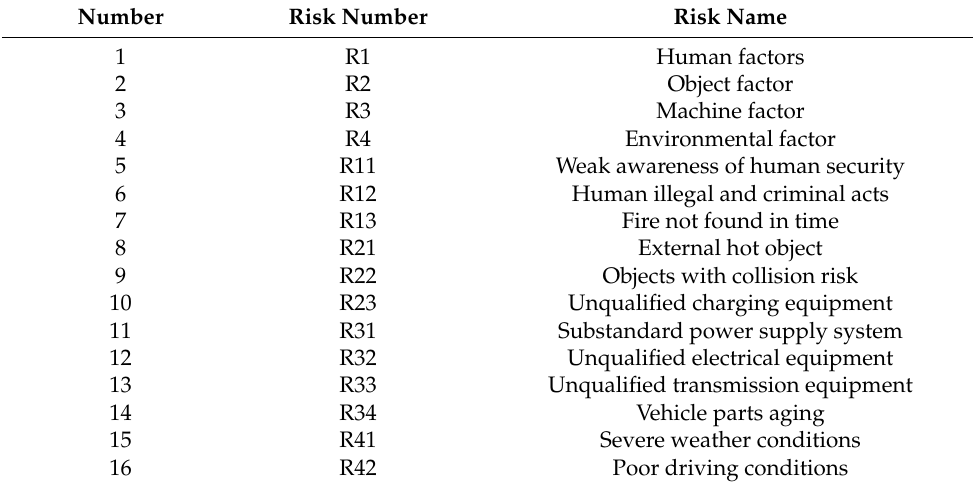
Figure 8. RBS structure tree of the electric vehicle fire. Table 3. Names of electric vehicle fire risk factors in RBS